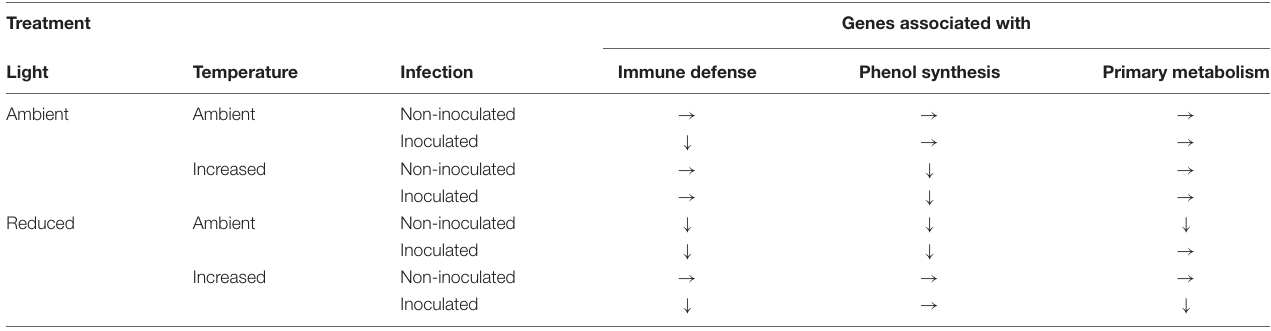
TABLE 5 | Expression of genes associated with immune defense, phenol synthesis, and primary metabolism in Zostera marina grown under different levels and combinations of light, temperature and Labyrinthula zosterae infection. Treatment Genes associated with Light